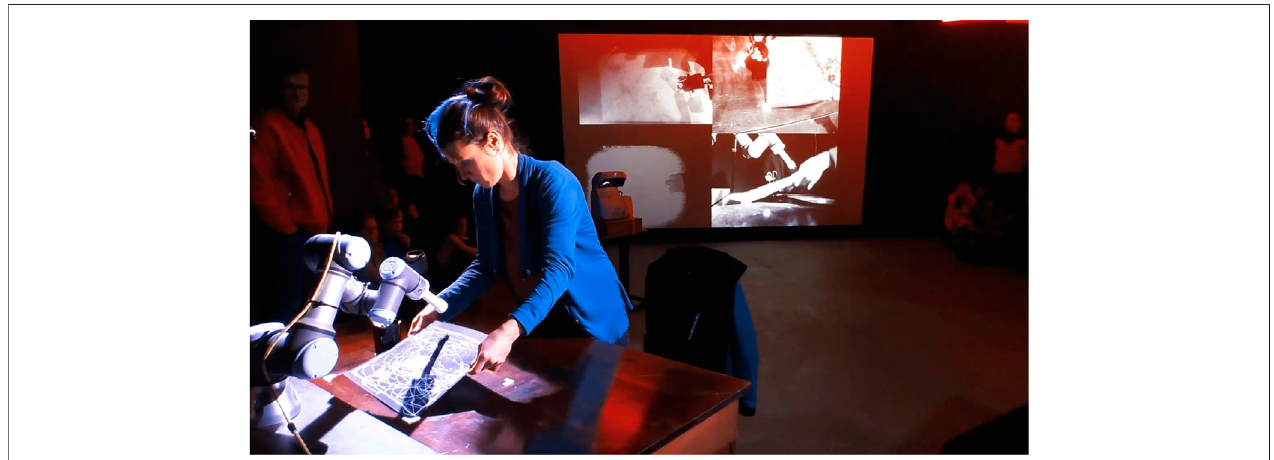
FIGURE 11 | The team performs If/Then performance at the museum. Rizzo works with the robot and executing a choreographed sequence in front of the audience. She controls the robot in “ free mode ” to get a drawing out of the drawing area.